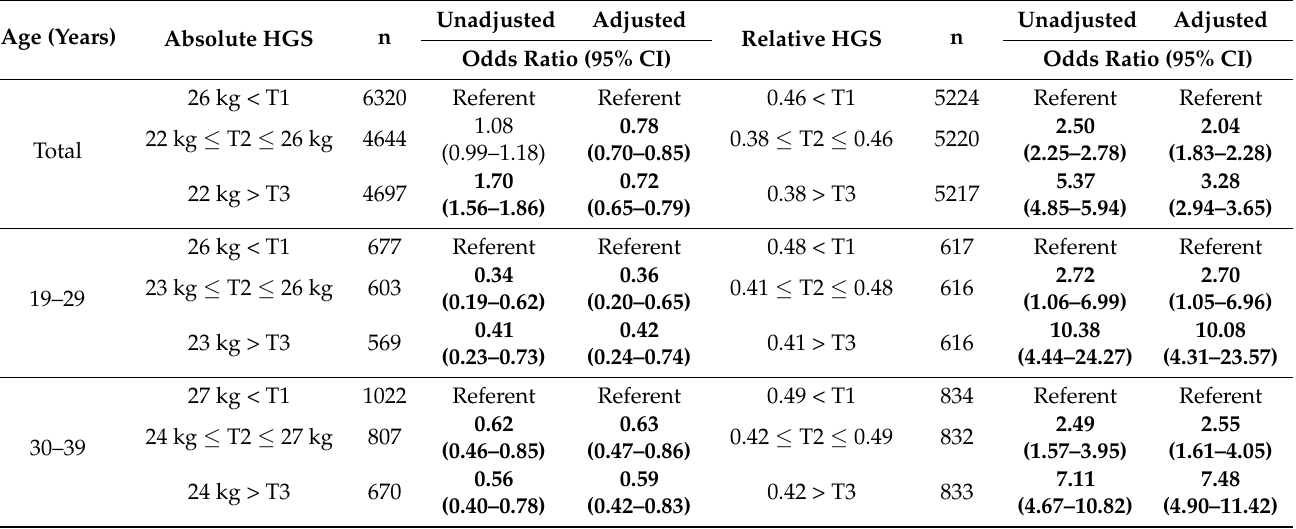
Table 3. Association between tertiles of handgrip strength and the prevalence of metabolic syndrome in females, stratified by